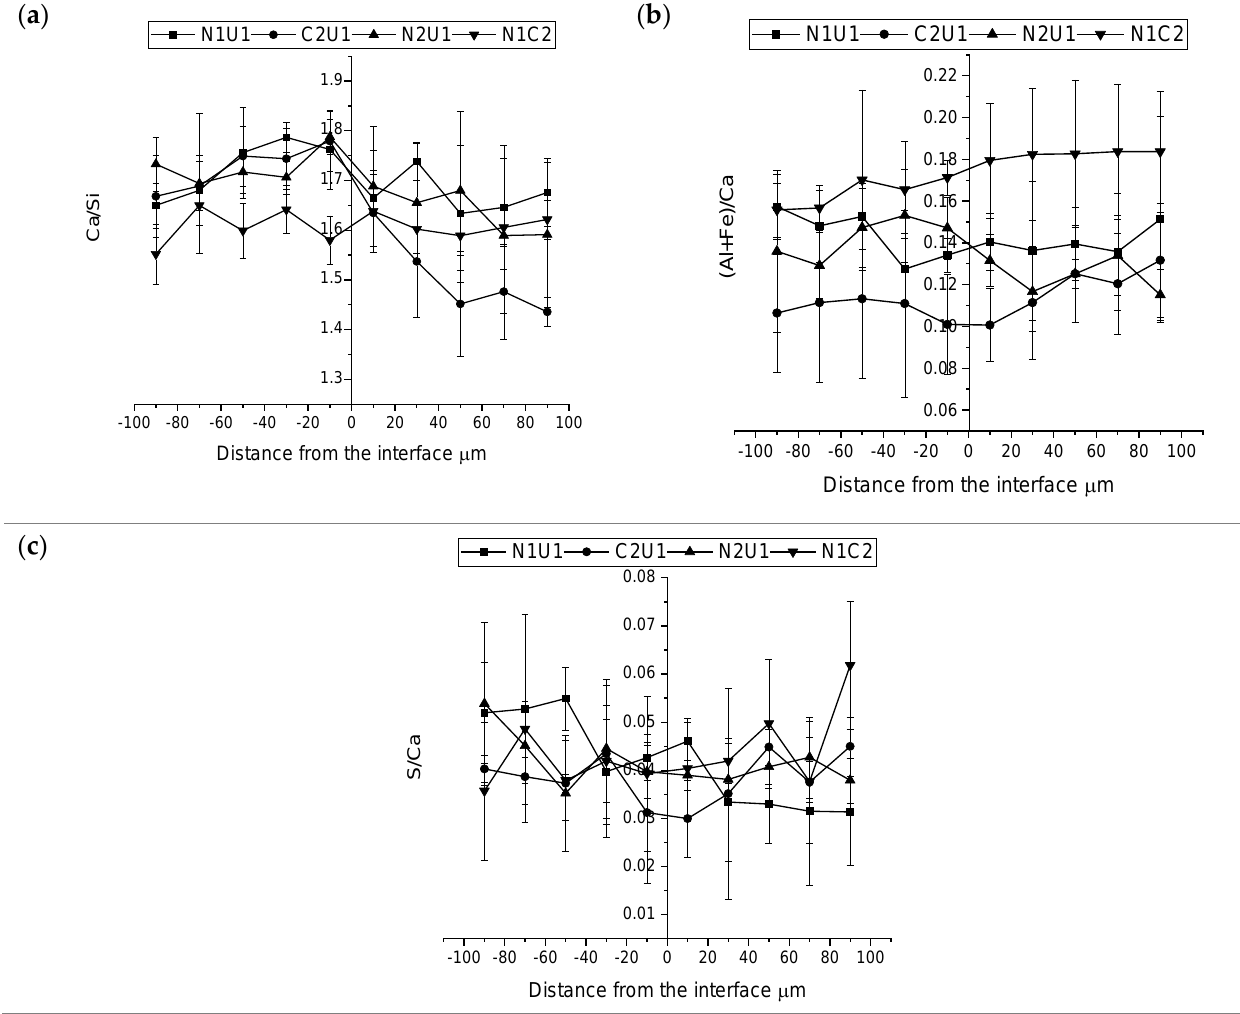
Figure 9 . Average atomic ratio and its corresponding standards deviations of hybrid